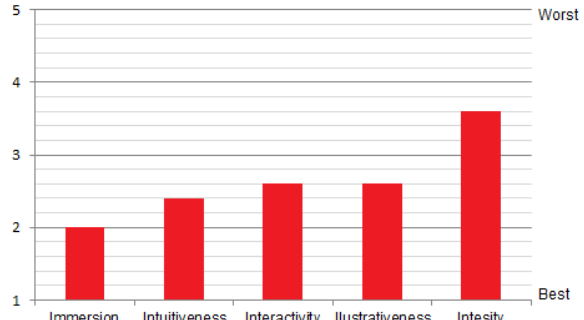
Figure 7. Results of satisfaction evaluation of “I” factors of